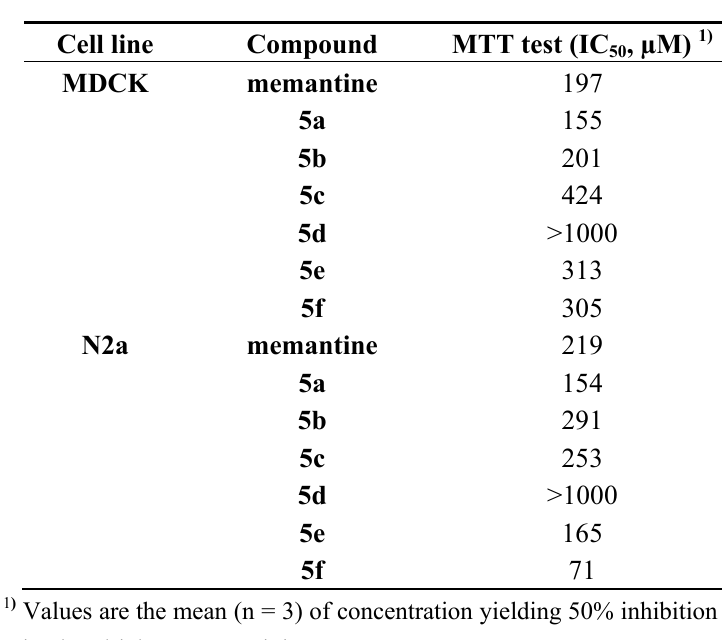
Table 1. The IC for novel NMDA receptor antagonists, and memantine on 50 MDCK and N2a